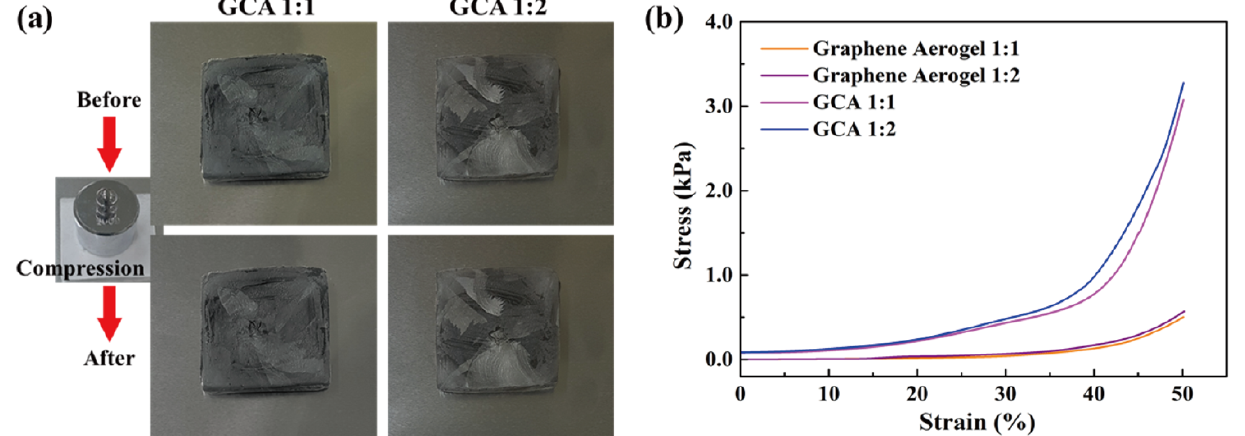
Figure 3. ( a ) Shape recovery test of GCA 1:1 and GCA 1:2. ( b ) Stress–strain tests of graphene aerogels and GCAs.